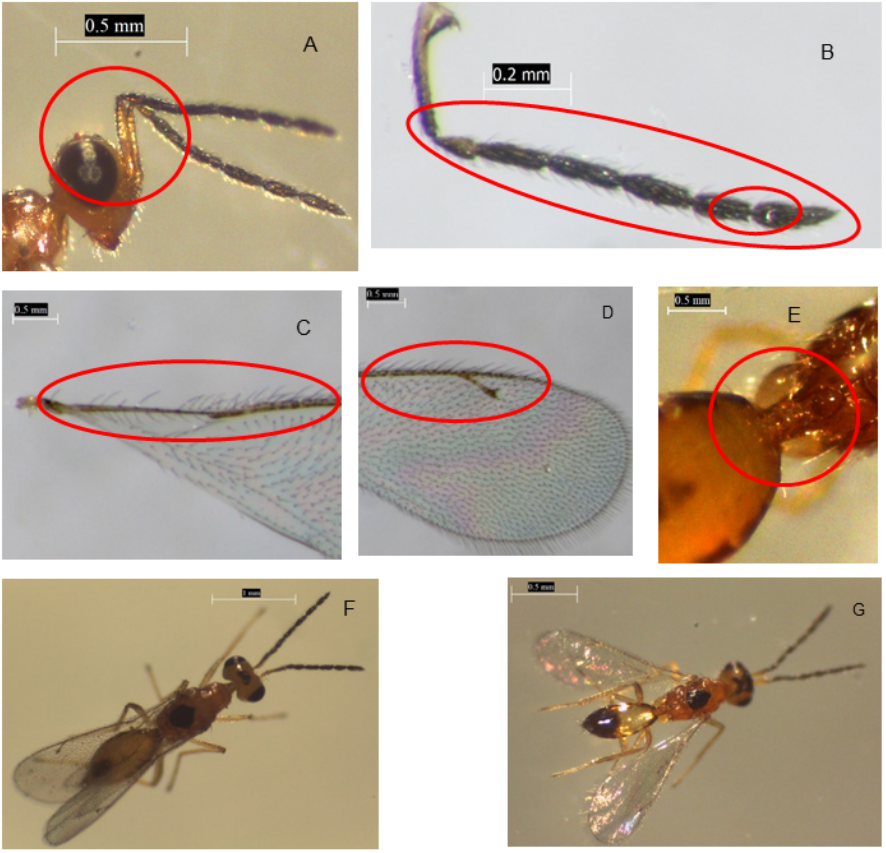
Figure 3. The collected Stenomesius sp. near japonicus description: ( A ): Scape and vertex, ( B ): Female antenna with scape slender and funicle 4-segmented, ( B ): The flagellum with 1–2 anelli, ( C ): Forewing with submarginal vein with more than 3: setae, ( D ): Postmarginal vein at least 1.5 times the length of the stigmal vein, ( E ): Petiole not separate, ( F , G ): Adult with X-shaped structure.